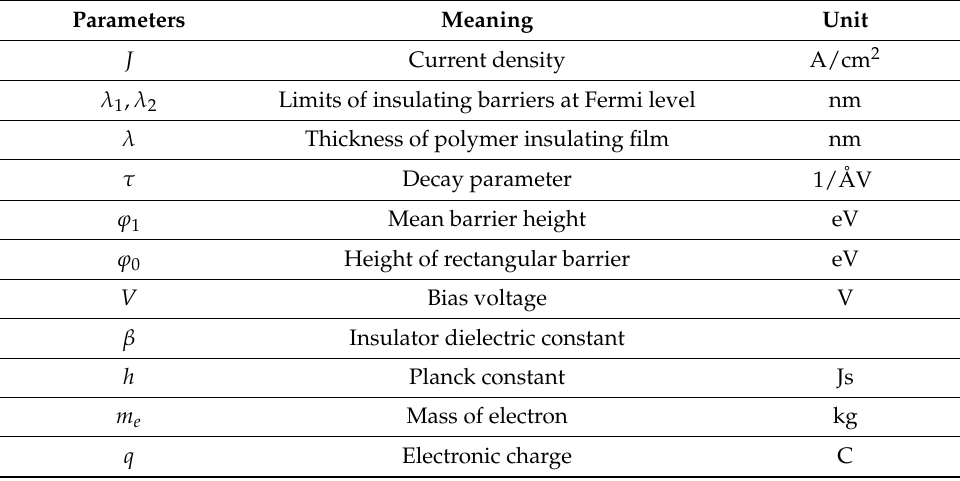
Table 1. The model